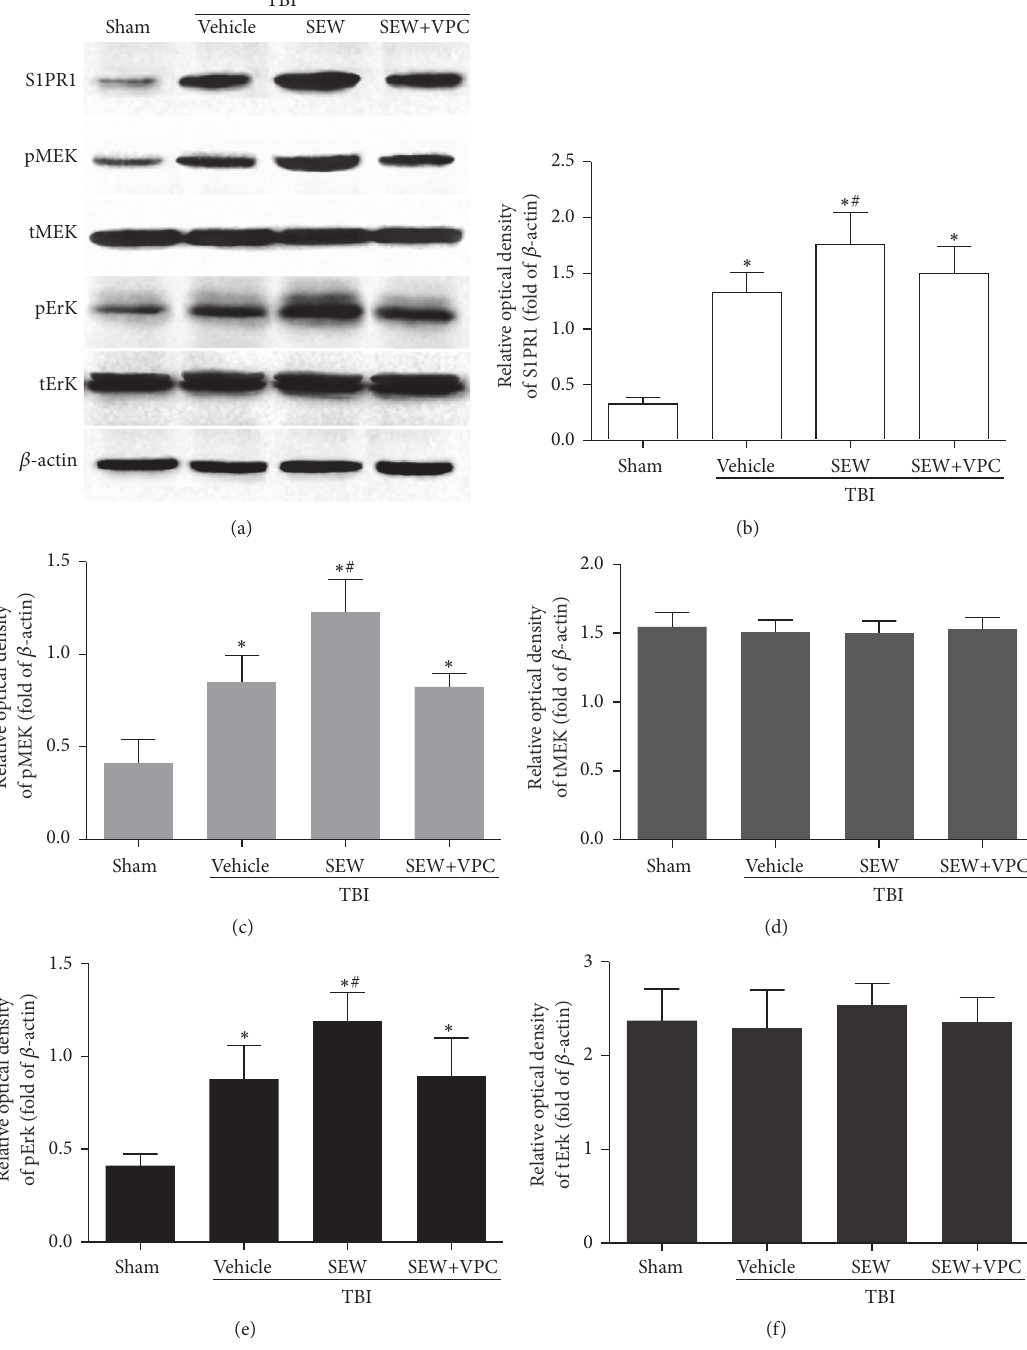
Figure 4: Activation of S1PR1 triggered MEK/Erk pathway phosphorylation in hippocampus at 7 days after TBI. (a) WB was performed to determine hippocampal S1PR1, pMEK, tMEK, pErk, and tErk expression in groups of sham, TBI+Vehicle, TBI+SEW, and TBI+SEW+VPC group ( 𝑛 = 3 in sham and 𝑛 = 6 in other groups). (b, c, and e) The level of S1PR1, pMEK, and pErk significantly increased after trauma. SEW2871 induced further upregulation of S1PR1, pMEK, and pErk. However, the effect was attenuated by administration of VPC23019. (d, f) Neither S1PR1 agonism nor antagonism had effect on tMEK and tErk expression in hippocampus after TBI. ∗ 𝑃 < 0.05 versus sham group; # 𝑃 < 0.05 versus TBI+Vehicle group or TBI+SEW+VPC